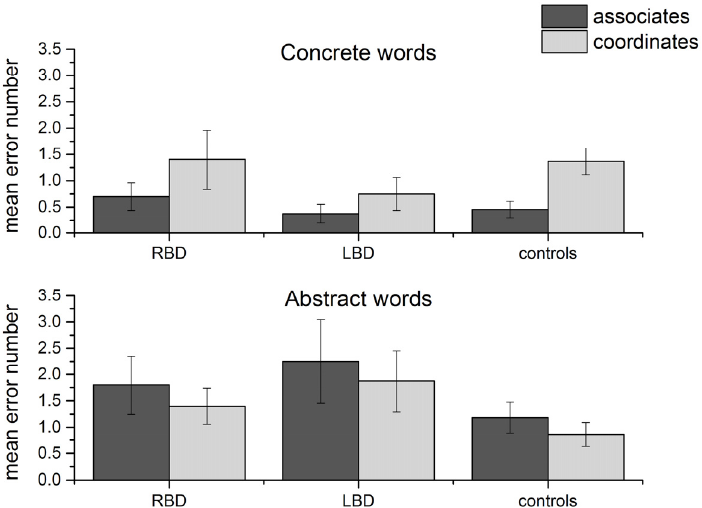
Figure 2. Number of errors for coordinate and associate target words in the three groups. Error bars represent standard errors of the mean.